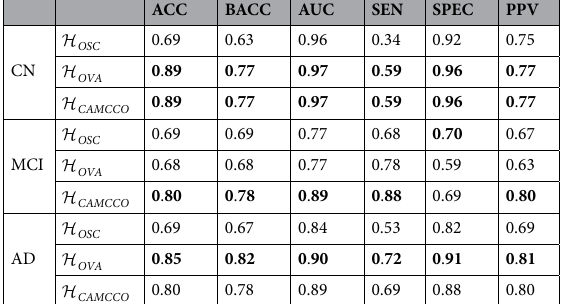
Table 6. Performance of multiclass classification strategies – one shot classifier (OSC), one vs. all (OVA), cascaded classifier in CaMCCo – upon fusion of modalities chosen from training set for each classification task. The highest accuracy (ACC), balanced accuracy (BACC), area under the ROC curve (AUC), sensitivity (SEN), specificity (SPE) and positive predictive value (PPV) achieved for each class are shown in bold. These results  and  indicate that although the performance of both are comparable for CN and AD OVA CAMCCO  outperforms all other methods for MCI classification, CAMCCO